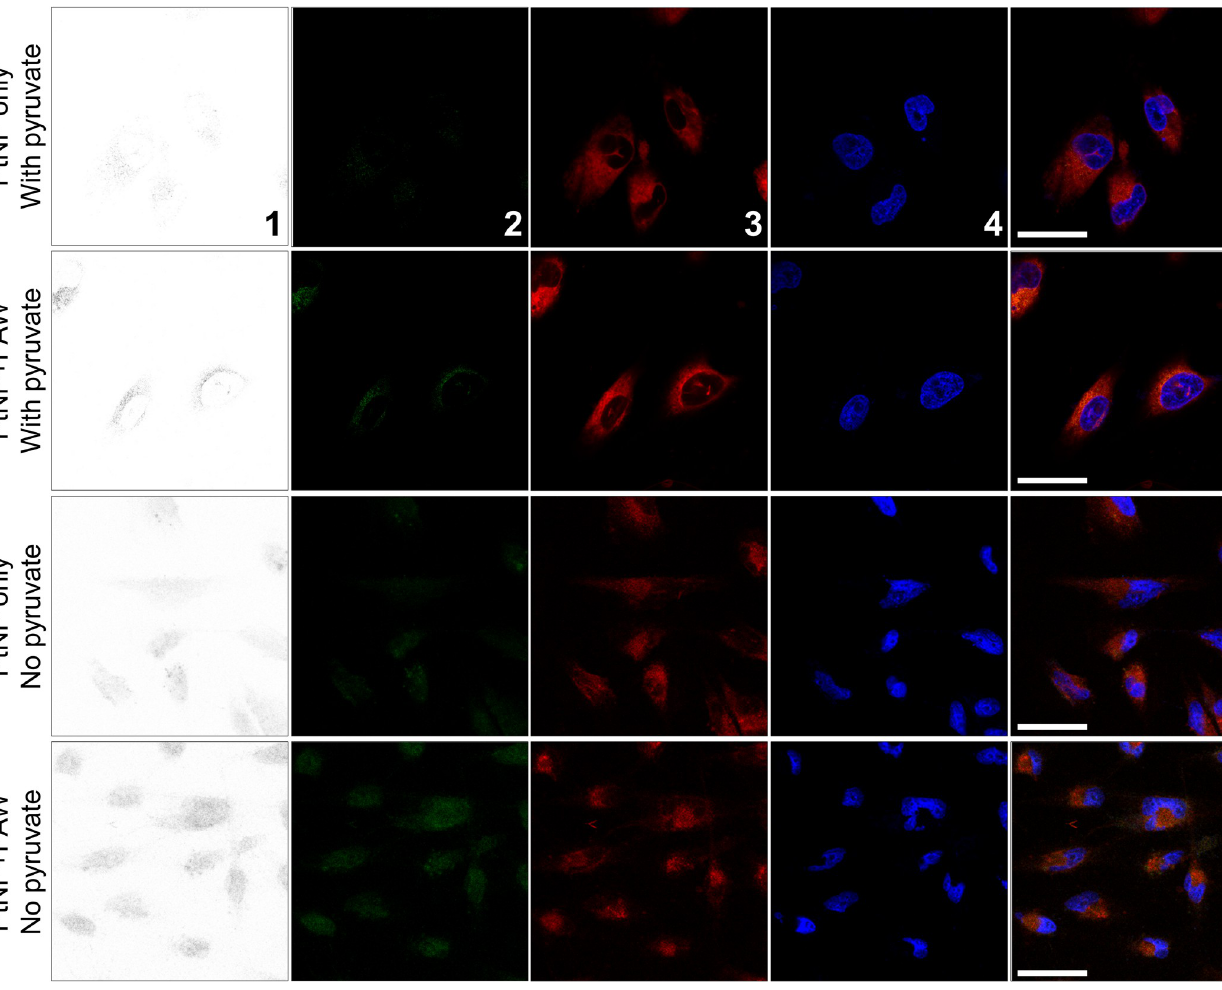
Fig 9. Lipid peroxidation assay. C11-BODIPY (581/591) staining shows increased lipid peroxidation induced by four hr treatment of 10% PAW in media without Pyruvate. Confocal imaging of C11-BODIPY loaded cells, 1 st to 5 th panels: Inverted, highlight oxidised form of C11-BODIPY using ImageJ; Green, oxidised form of C11-BODIPY; Red, reduced form of C11-BODIPY; Bule, NucBlue staining showing nucleus; Merged images (blue, green and red channels); Scale bar (from top to bottom, 30 μ m, 30 μ m, 50 μ m, 50 μ m).